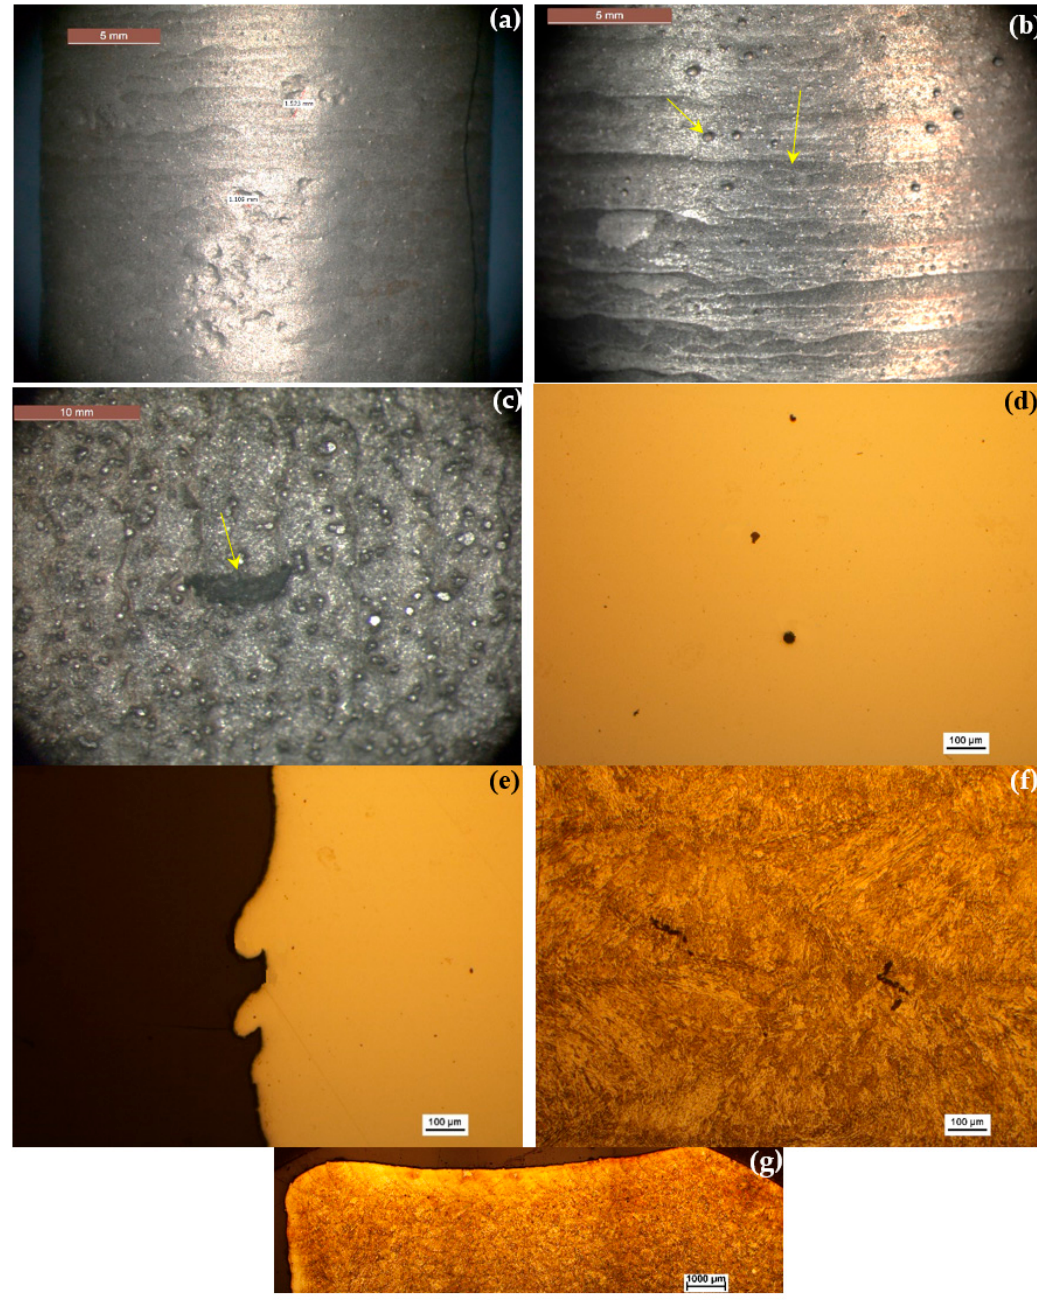
Figure 5. Microscopic characterization of the 17-4 PH stainless steel rod. Stereomicroscope images revealing open porosity ( a ), deposition layers and partially melted powder particles ( b ), and a cavity due to lack of fusion ( c ). Non-etched metallographic longitudinal cross-sections reveal few pores, local chemical inhomogeneity, or both, in the bulk alloy ( d ) and high surface roughness ( e ). A uniform martensitic microstructure ( f ) and overbuild at the top edges ( g ) after chemical etching.